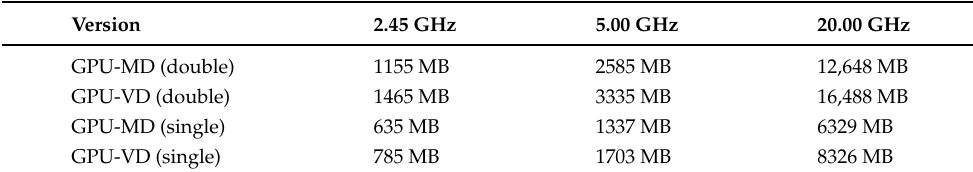
Table 10. Memory used in the GPU, for the parabolic reflector propagation.